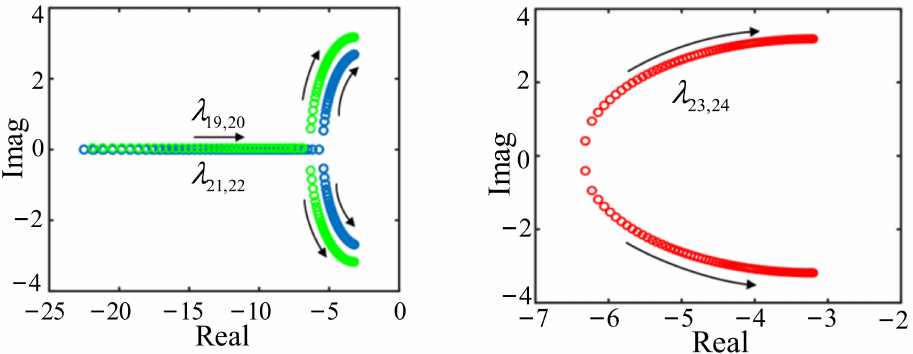
Figure 10. Eigenvalue trajectories of system under different virtual inertias.